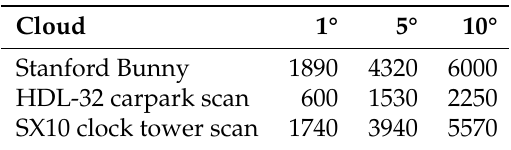
Table 3. Distance-Density Ratio at which the mean normal orientation error passes X° when calculated with